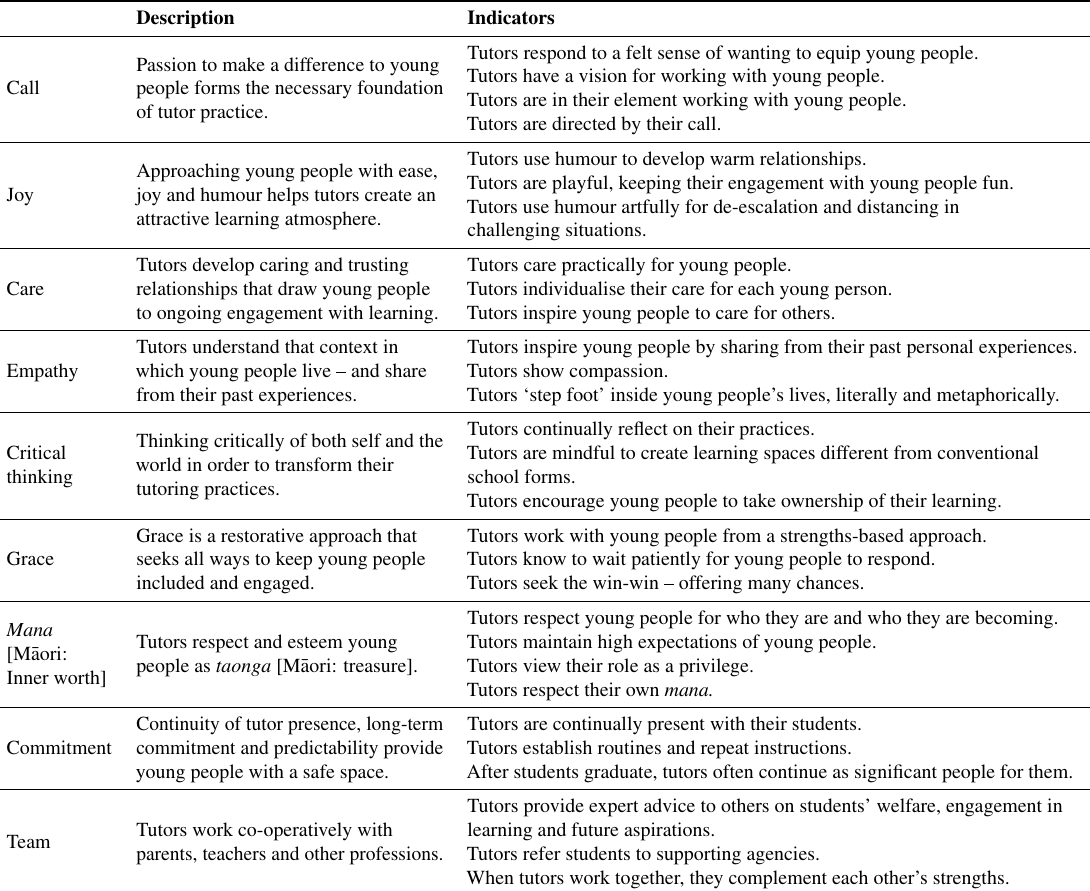
Table 2. Tutor character (Schoone, 2016, pp.